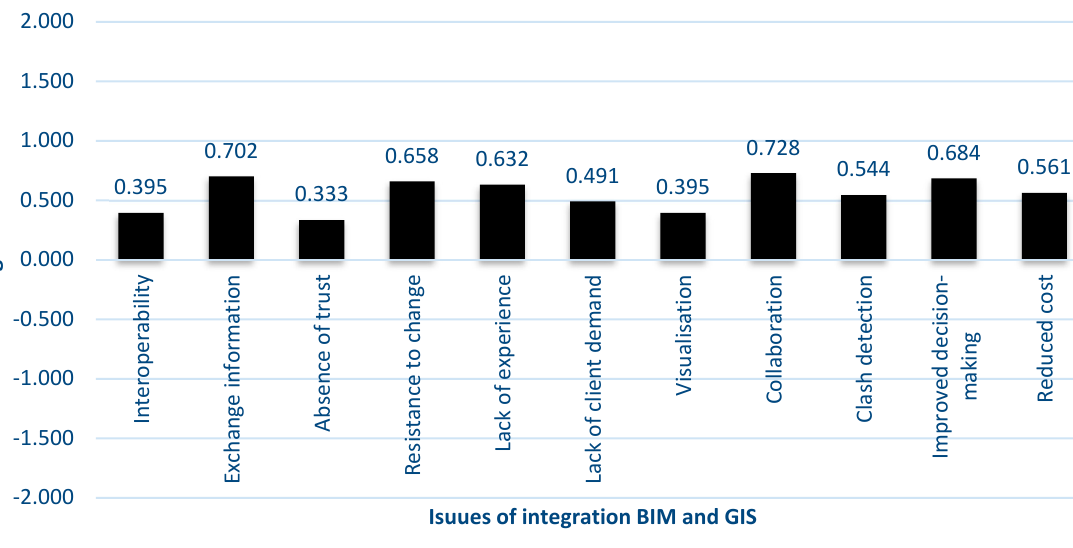
Figure 8. Barriers to Integrating BIM and GIS in the Design Stage in Rail Projects.